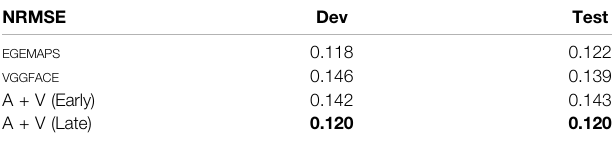
Emphasised results indicate strongest performance on given evaluation